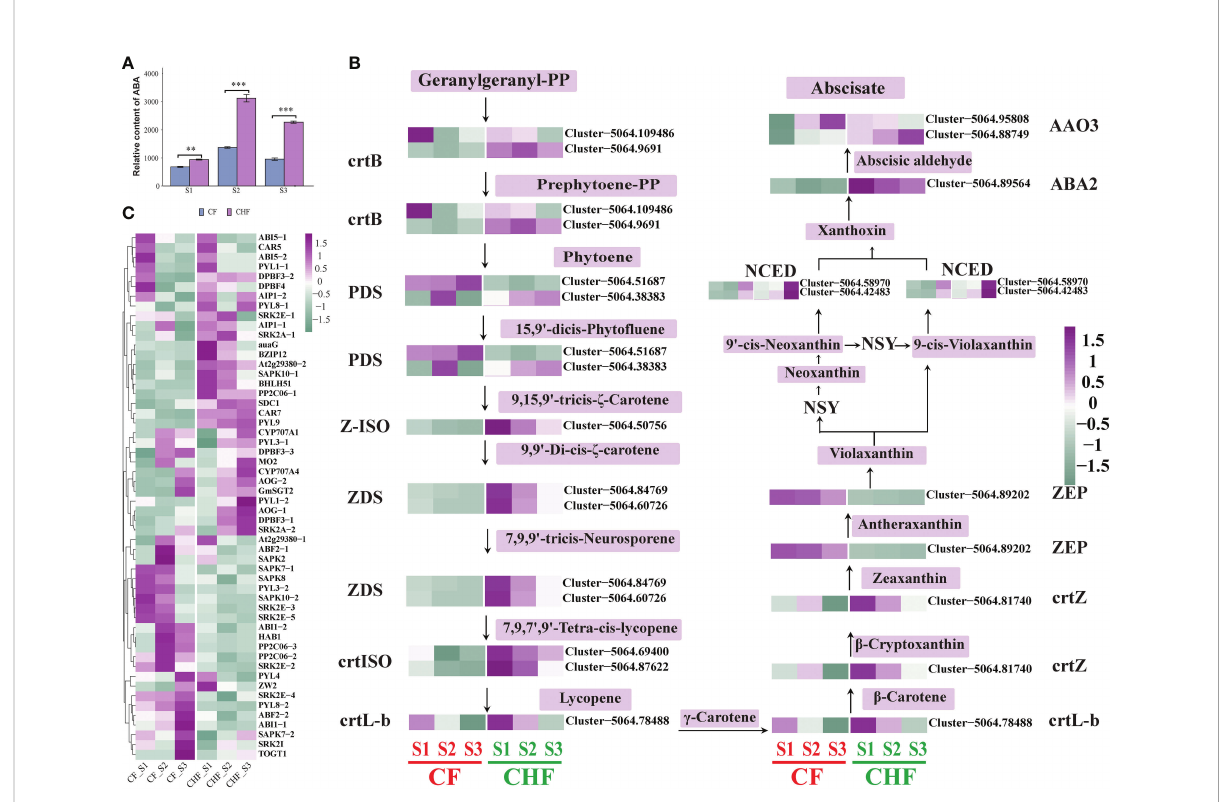
FIGURE 4 Alteration in gene expression associated with ABA biosynthesis and signal transduction in CF and CHF. (A) Variations in the ABA content of CF and CHF receptacles. (B) Variations in ABA biosynthesis structural gene expression. (C) Changes in gene expression associated with ABA signal transduction and response genes related to ABA. **P < 0.01 and ***P <